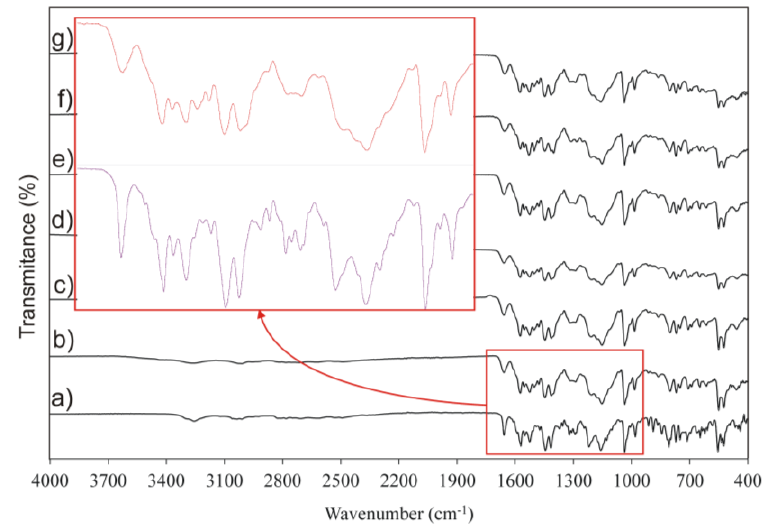
Figure 7. Attenuated total reflectance-Fourier transform infrared spectroscopy (ATR-FTIR) spectra crystalline imatinib mesylate (IM) ( a ) and amorphous IM stored at 25 °C under controlled relative humidity at different ageing times: ( b ) day 0, ( c ) 2 weeks, ( d ) 1 month, ( e ) 3 months, ( f ) 6 months, and ( g ) 15 months.